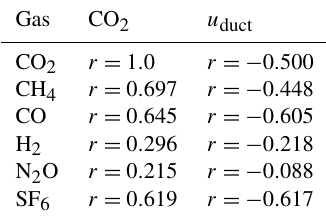
Table 4. Correlations (r) between the detrended mlo–cgo gas anomalies for CO 2 , CH 4 , CO, and H 2 with CO 2 and indices of mean transport, ω P , and v P averaged between June–August for 1992–2016. Also shown are corresponding correlations for N 2 O and 1993–2016 and for SF 6 and